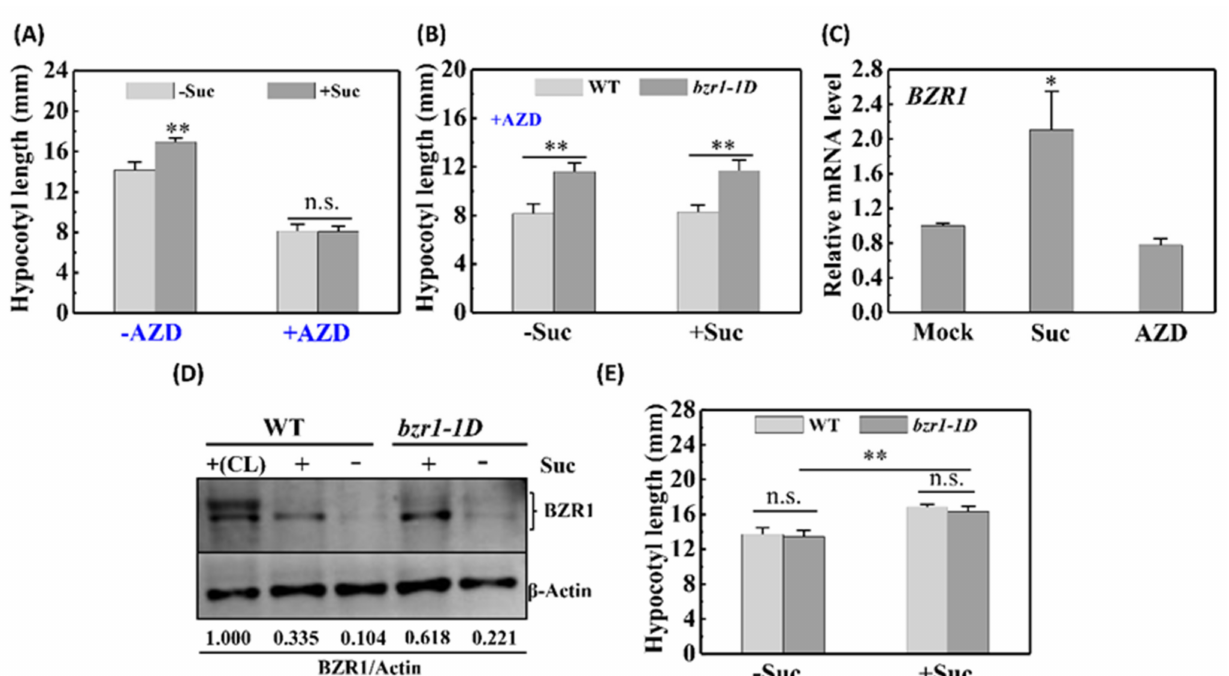
Figure 2. Activation of TOR kinase and accumulation of BZR1 play a role in sugar-induced skotomorphogenesis. ( A ) TOR kinase is essential for skotomorphogenesis. ( B ) Hypocotyl length of wild-type (WT) and bzr1-1D etiolated seedlings treated with 1 µ M AZD ± 30 mM sucrose. ( C ) Expression pattern of the bzr1 gene in WT etiolated seedlings treated with 30 mM sucrose or 1 µ M AZD. Values are presented as the means ± SD of three independent sets of experiments. ( D ) Immunoblot analysis of BZR1 protein in WT and bzr1-1D seedlings grown in the dark on medium with (+) or without ( − ) 30 mM sucrose. The upper and lower bands indicate phosphorylated and dephosphorylated BZR1, respectively. (CL) indicates that plants were grown in continuous white light. ( E ) Hypocotyl length of WT and bzr1-1D etiolated seedlings treated with or without 30 mM sucrose. Error bars for standard deviations ( n > 20). Data were statistically evaluated using Student’s t -test, and the significance of differences (**, p < 0.01; *, p < 0.05; n.s., not significant) is